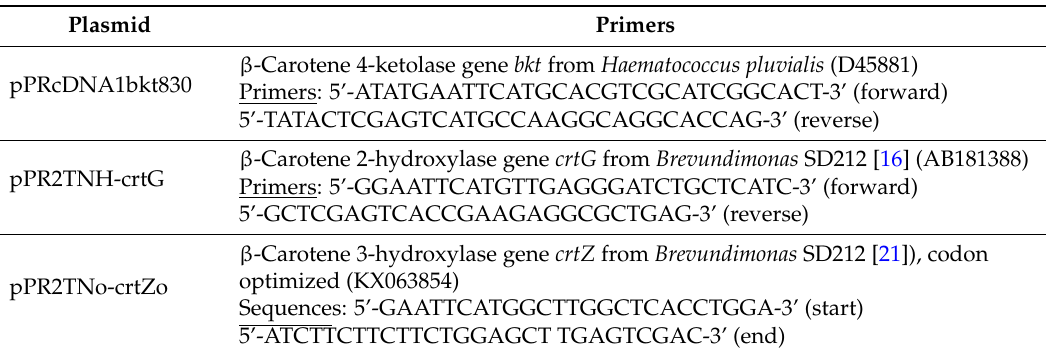
Table 1. Genes and oligonucleotides for PCR amplification of the Xanthophyllomyces dendrorhous transformation